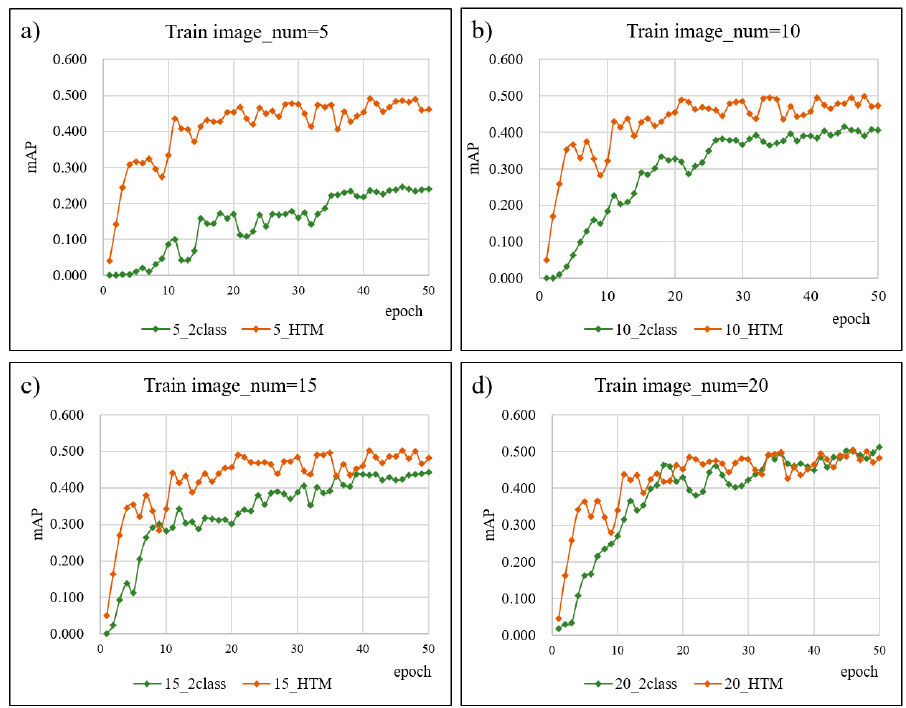
Figure 6. The mAP 50 for each model. ( a ). sample size = 5; ( b ) sample size = 10; ( c ) sample size = 15; ( d ) sample size = 20.